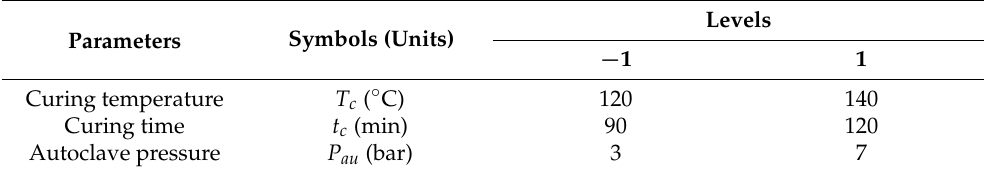
Table 1. Summary of designed curing parameters levels for experimentation.